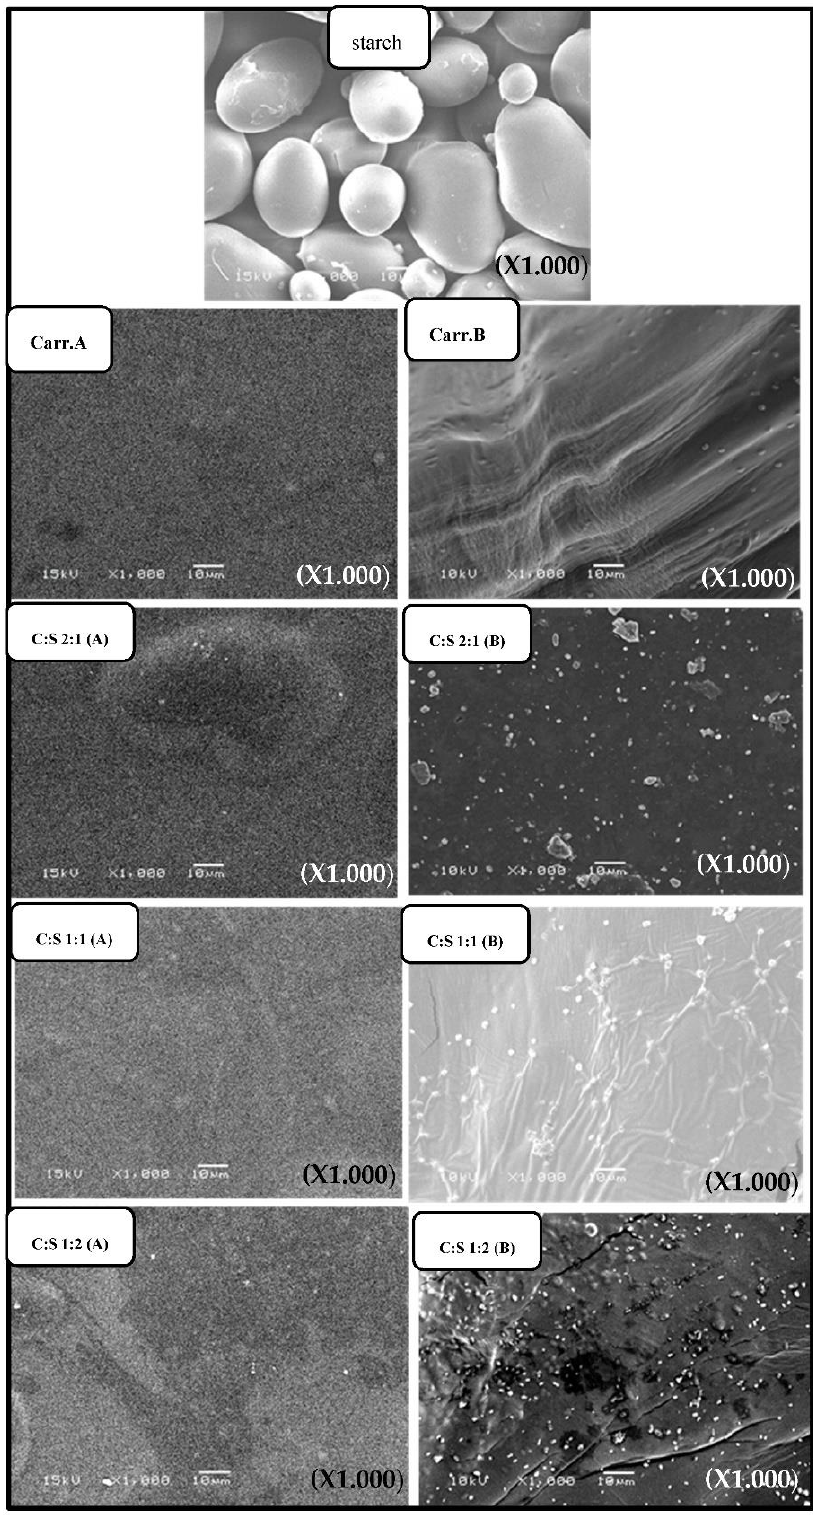
Figure 5. SEM micrograph of surface of starch, Carr, and Carr/starch blend-based membranes before ( A ) and after ( B ) enzymatic treatment at magnification power of 1000×.